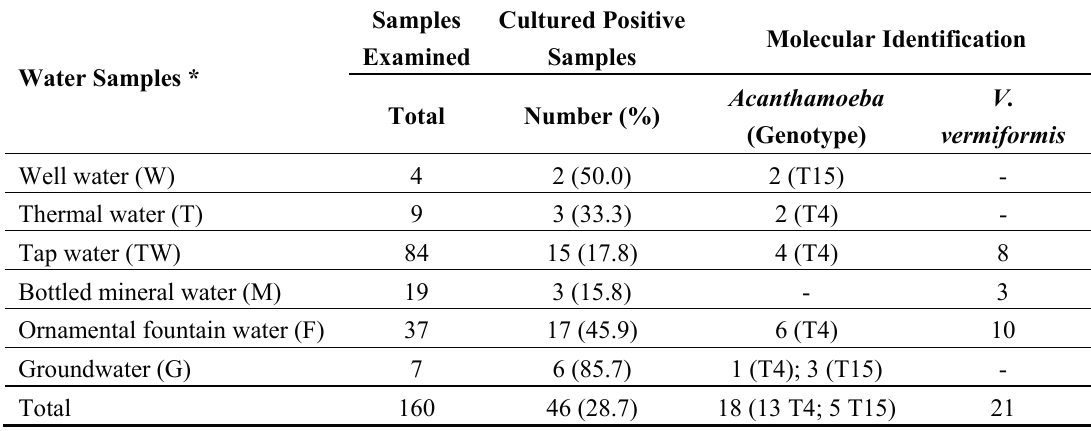
Table 1. Water isolation sources, number of samples examined and results obtained by culture and molecular analysis of free-living amoebae in